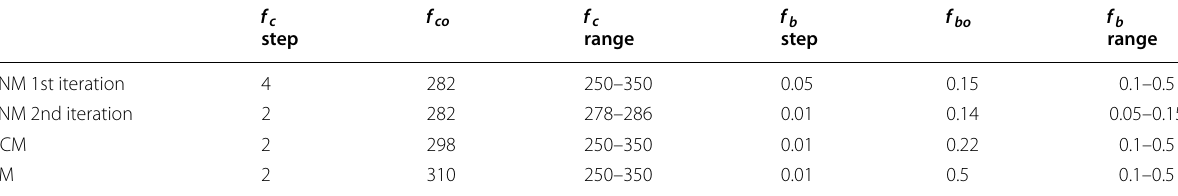
Table 2 Searching